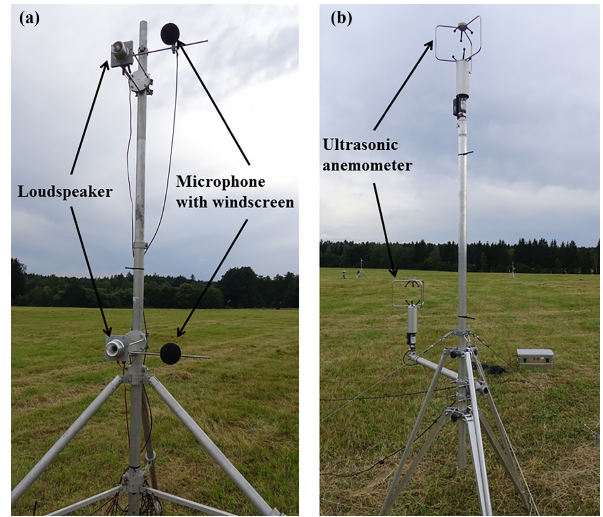
Figure 2. (a) Telescopic mast (A-TOM2) with acoustic equipment at two height levels, 1.5 and 3m, above grassland, single tree line 220m away, and Tharandt Forest at a distance of 450m in the back- ground (southwest direction). (b) Telescopic mast with ultrasonic anemometers at 1.5m and 3m height